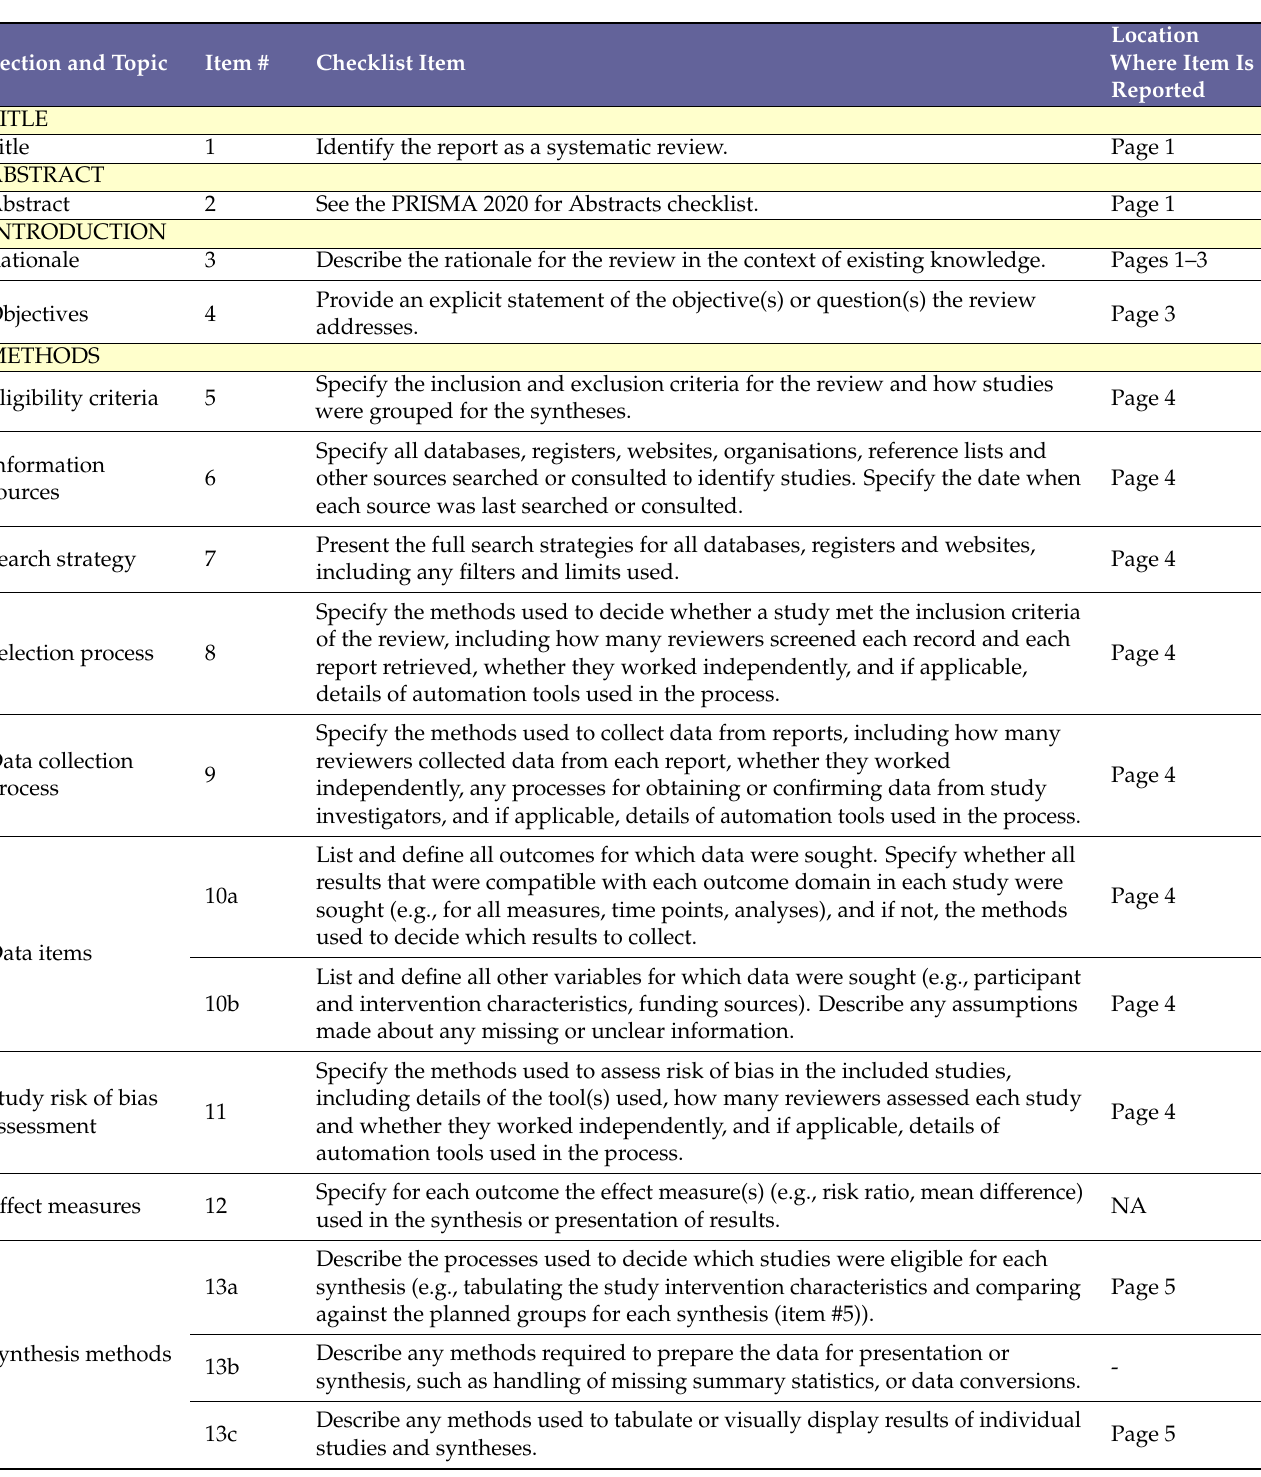
Table 1. PRISMA 2020